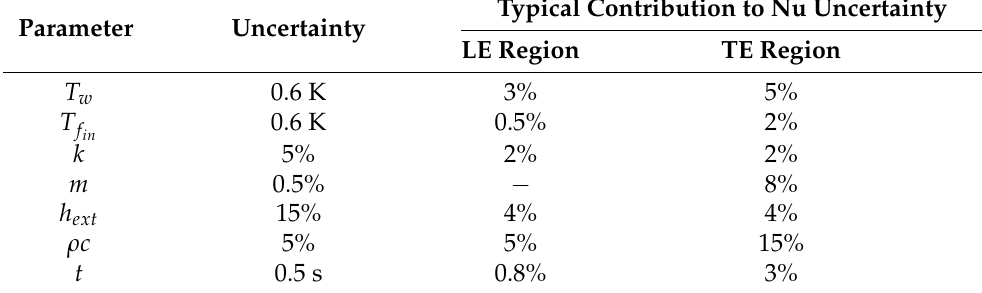
Table 2. Contribution to the uncertainty on Nu for